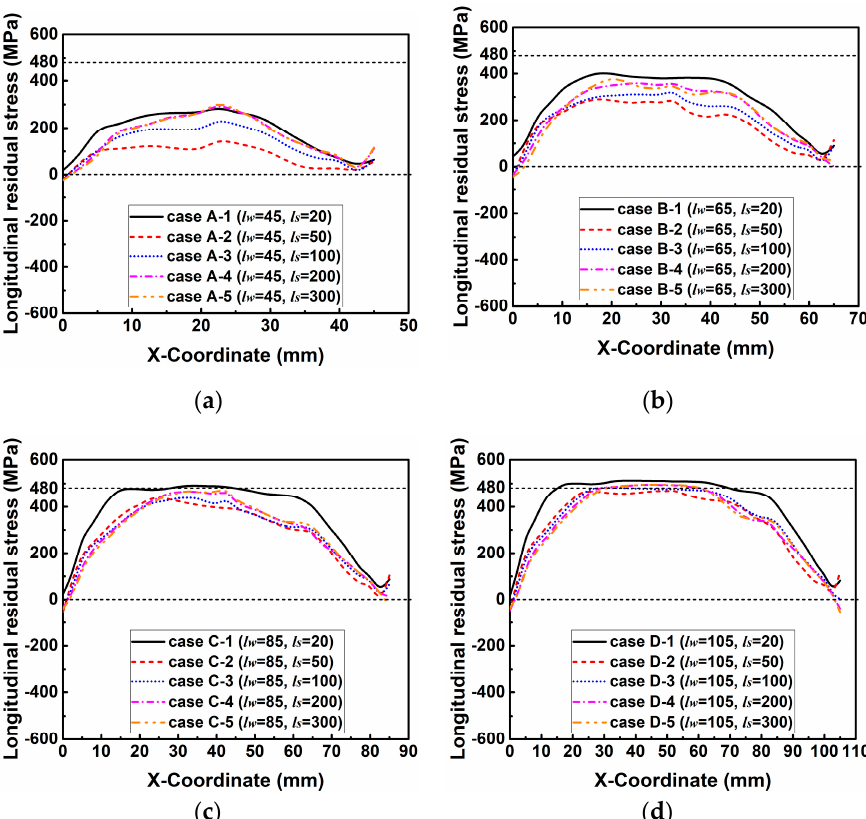
Figure 15. Longitudinal residual stress distributions along line 2 in the cases of each group with varied slit length ( l s ) while the weld length ( l w ) is kept constant: ( a ) Group A; ( b ) group B; ( c ) group C; ( d ) group D.